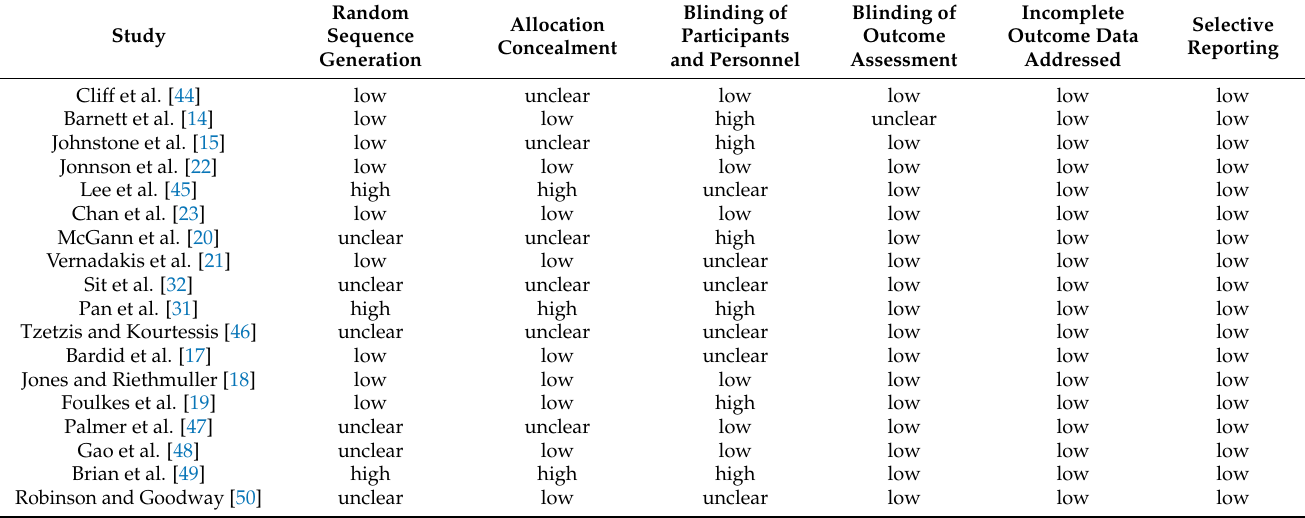
Table 1. Cochrane Risk of Bias Assessment for Randomized Controlled Trials (low, high,